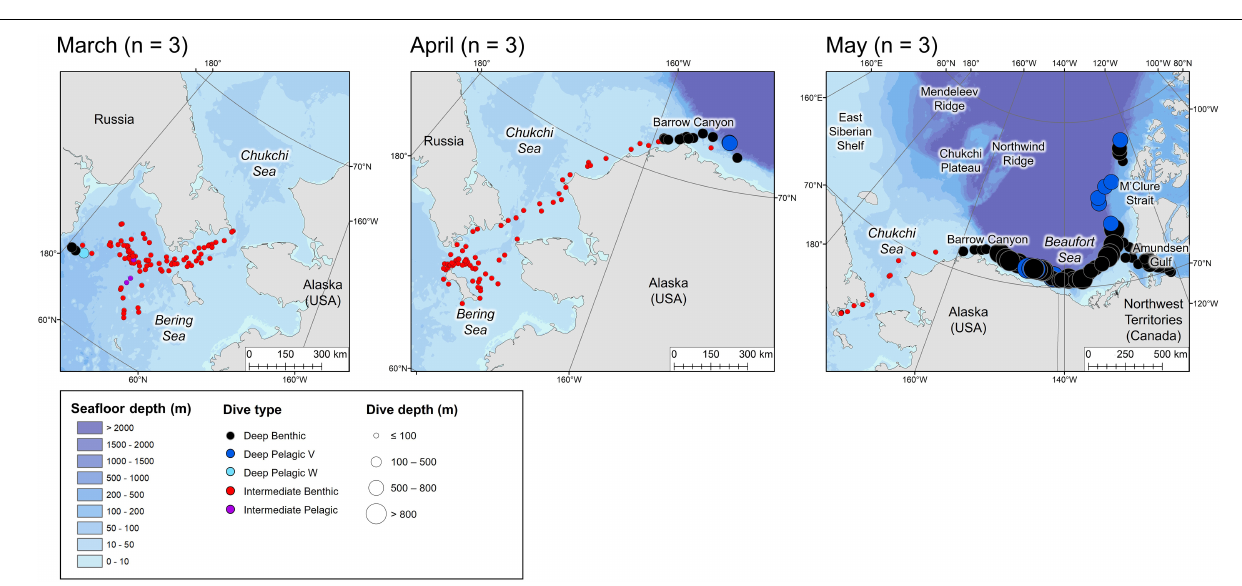
FIGURE 5 | Locations of the daily deepest dive made by each beluga during the winter months. Symbol color represents dive type and symbol size represents the maximum depth reached. n in parentheses gives the number of belugas which transmitted data in the given month.